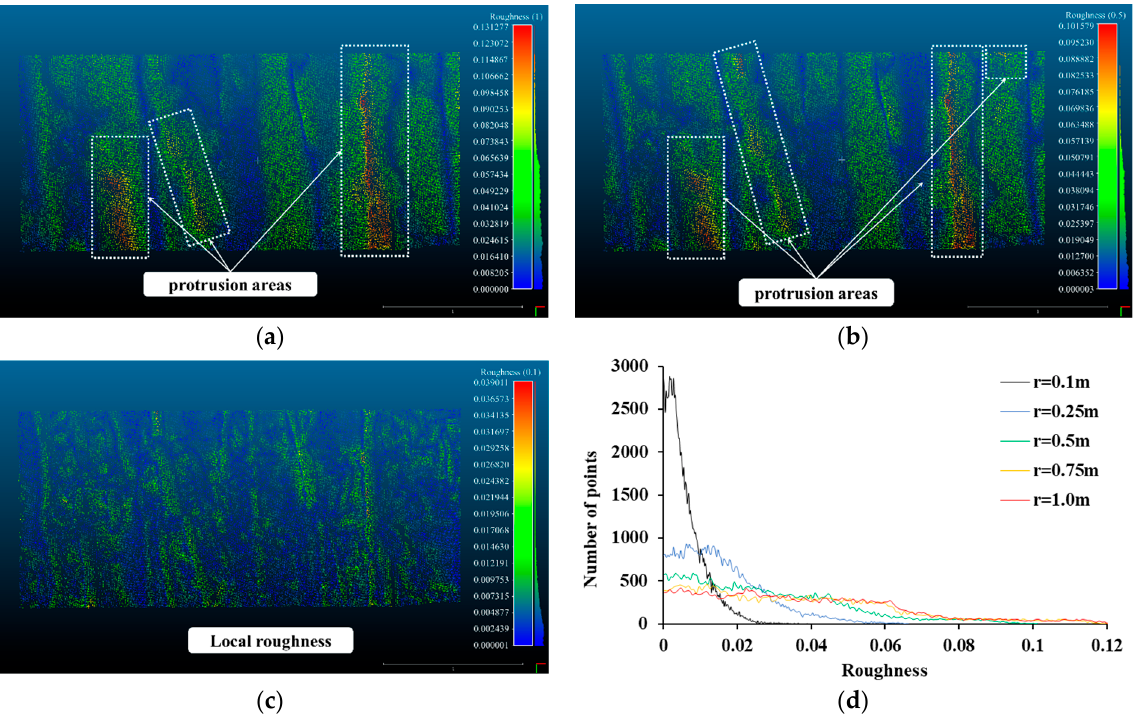
Figure 6. Roughness of soil mixing wall, ( a ) Kernel radius = 1.0 m, ( b ) Kernel radius = 0.5 m, ( c ) Kernel radius = 0.1 m, ( d ) Histogram of roughness.